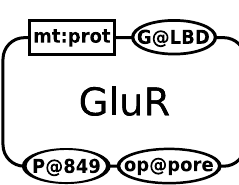
Figure 2.17: An example of a glutamate receptor in the open state.